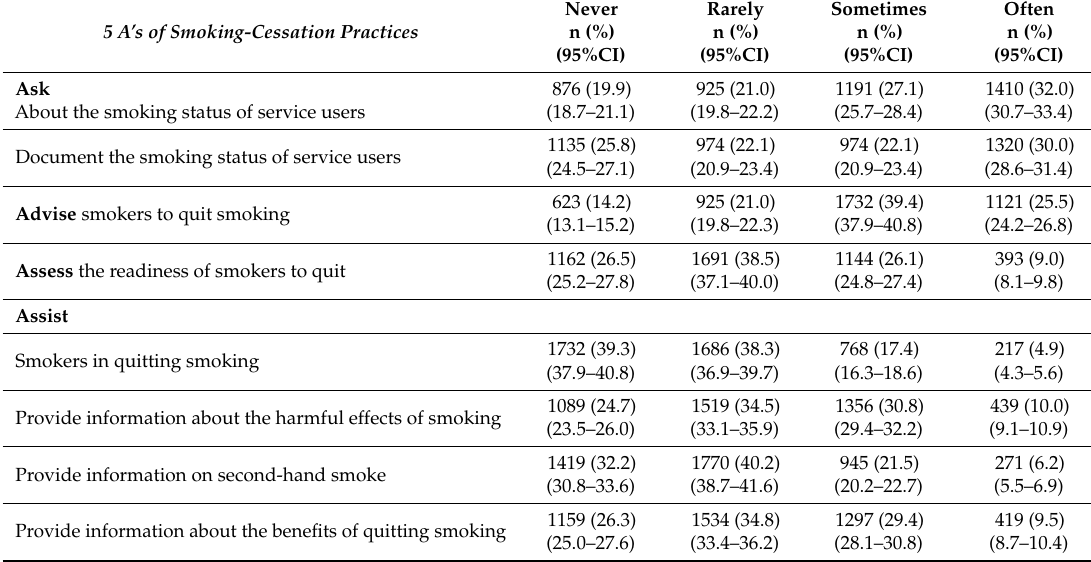
Table 6. Nurses’ practice of the 5 A’s of smoking cessation: Ask, Advise, Assess, Assist, Arrange (N = 4413) #